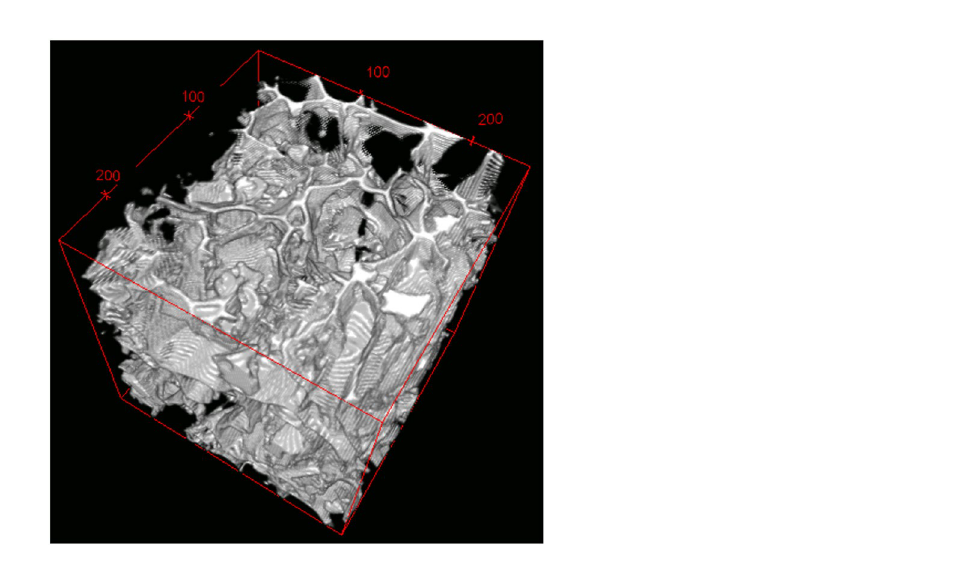
Figure 7. The 3D image of the foam microstructure (Volume of Interest of 250 μm × 250 μm × 250